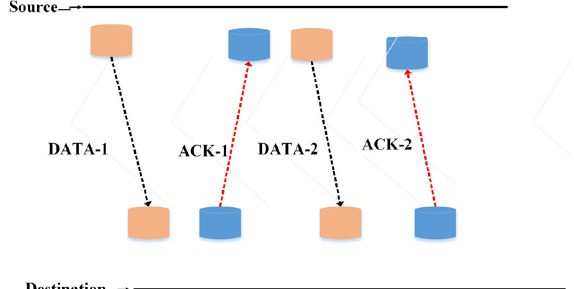
Figure 3. Procedure of sending and receiving data packets [43].